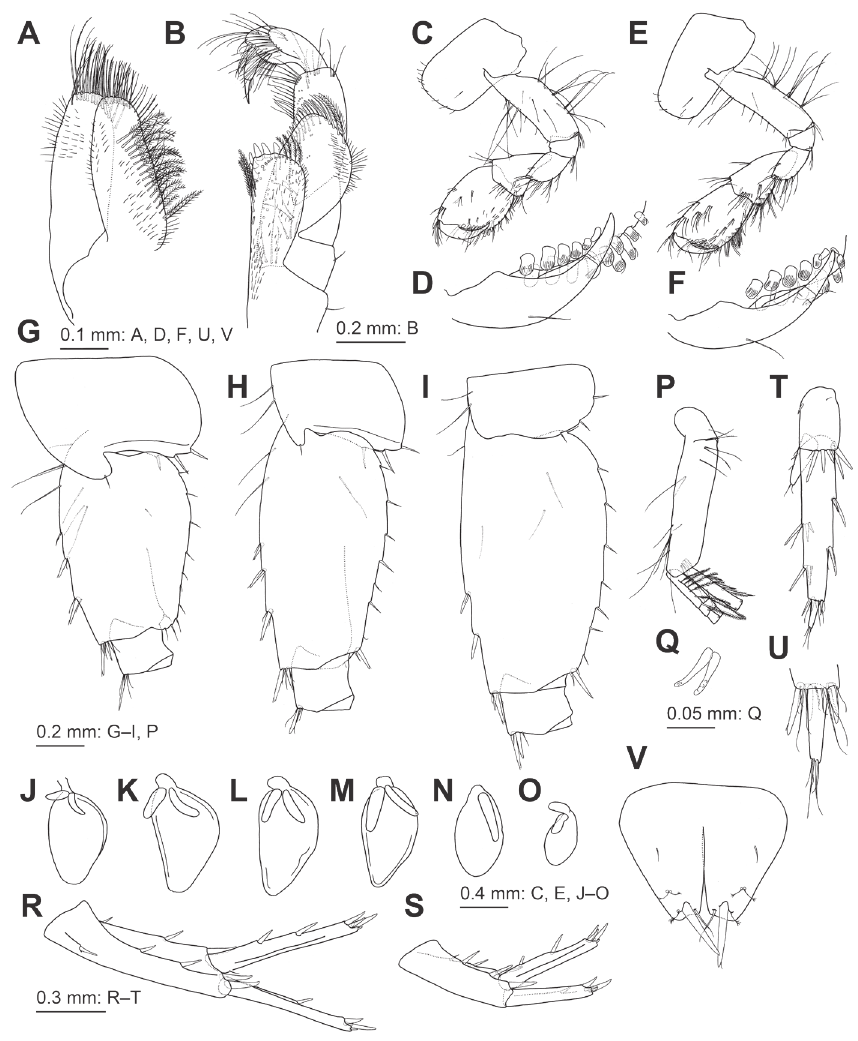
Figure 4. Jesogammarus ( Jesogammarus ) acalceolus sp. nov., male (7.4 mm), NSMT-Cr 29003 A maxilla 2, medial view B maxilliped, dorsal view C gnathopod 1, medial view D palmar margin of propodus and dactylus of gnathopod 1, medial view, some setae omitted E gnathopod 2, medial view F palmar margin of propodus and dactylus of gnathopod 2, medial view, some setae omitted G–I coxa-ischium of pereo- pods 5–7, respectively, lateral views J–O coxal gills on gnathopod 2–pereopod 7, respectively, lateral views P pleopod 1, lateral view, distal parts of rami omitted Q retinacula on peduncle of pleopod 1, lateral view R–S uropods 1–2, respectively, dorsal views T uropod 3, ventral view U distal part of proximal article and terminal article of outer ramus of uropod 3, ventral view V telson, dorsal